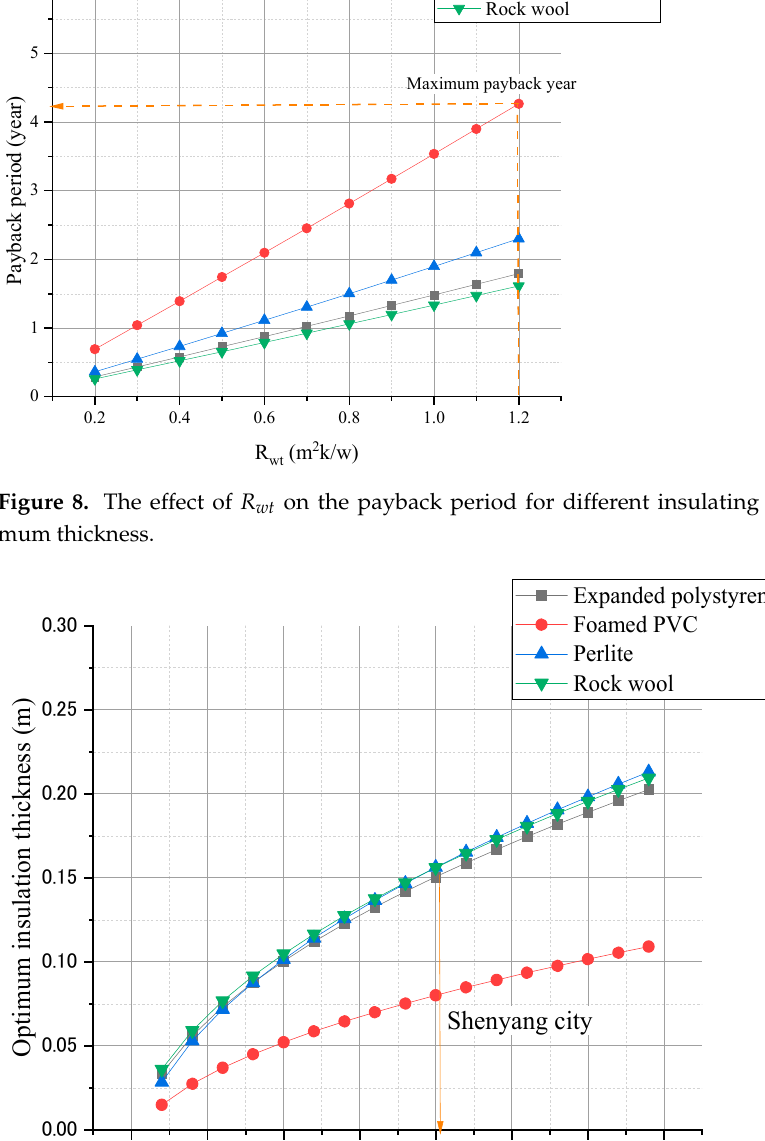
Figure 9. The effect of degree-days on the optimum thickness of insulating materials.